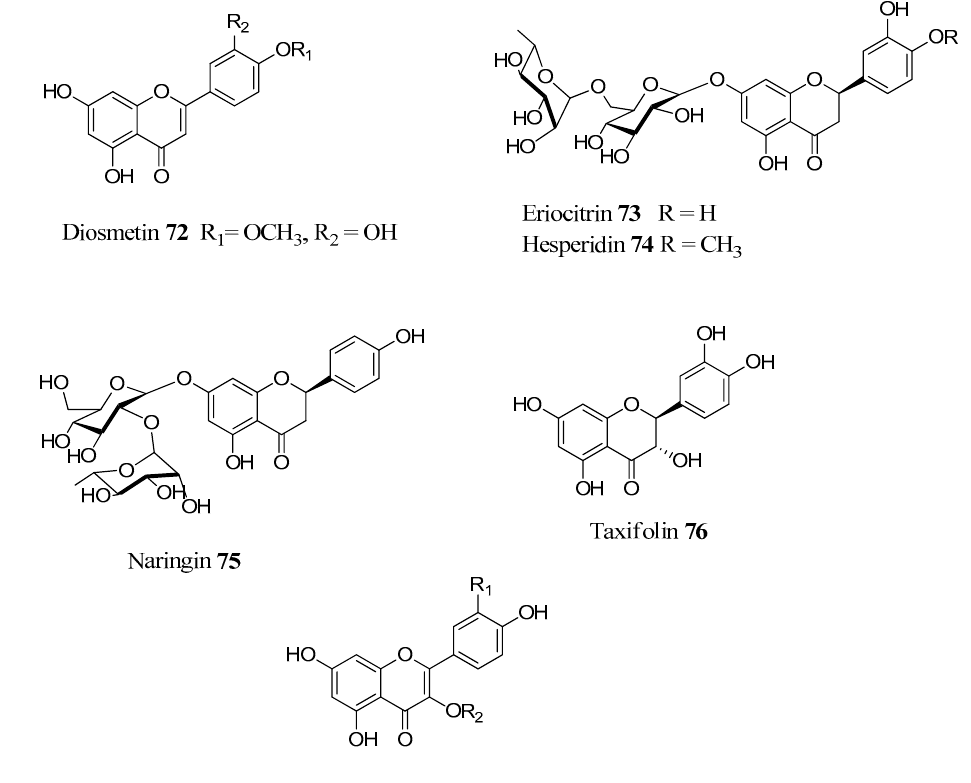
Figure 16. Structures of compounds 72 – 77 [69].